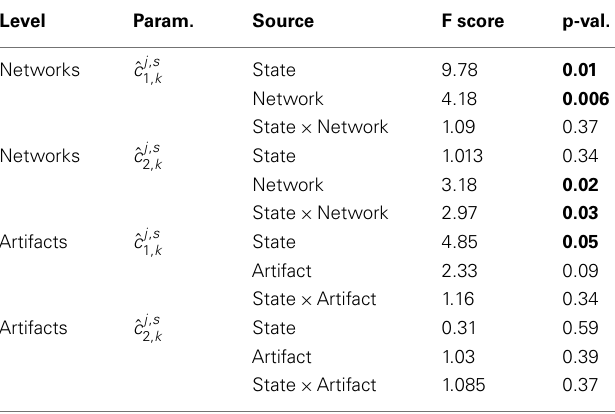
Table 2 | 2-way repeated measuresANOVA results based on the ˆ c j , s parameters for i = {1, 2}, j = (R,T), s = 1: S , and k ∈ F (top), k ∈ A (middle), k ∈ U (bottom).